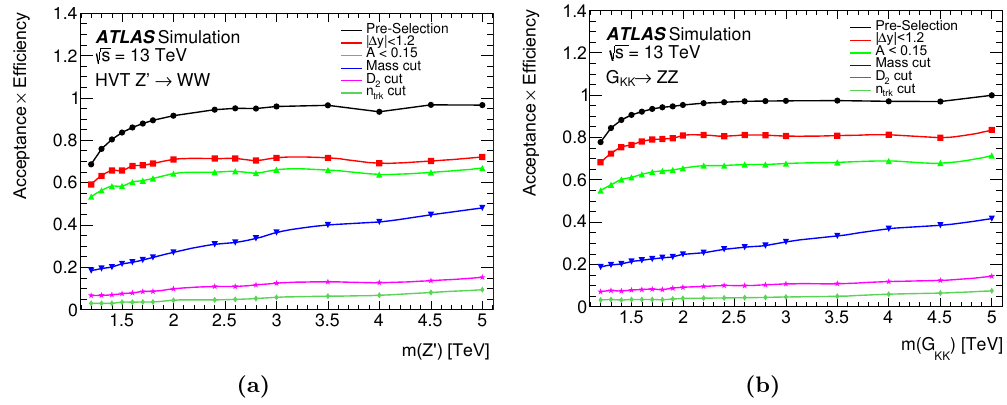
Figure 5 . The acceptance (cid:2) e(cid:14)ciency for the selection, de(cid:12)ned as the number of selected events at di(cid:11)erent stages of the selection divided by the number of generated events, for (a) HVT Z 0 ! WW and (b) G ! ZZ as a function of mass. The selections are applied in sequence and include KK pre-selections, topological selections on j (cid:1) y j , p asymmetry A , and boson tagging using jet mass, 12 T D , and n 2 trk